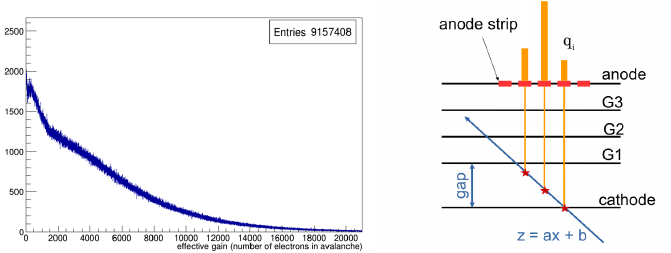
Figure 2: Left: e ff ective gain for a triple-GEM. The histogram is the result of the full chain of simulations of the gain, collection and extraction e ffi ciencies for the three GEMs. The contribution of zero e ff ective gain is removed from the histogram. Right: sketch of a triple- GEM detector with the cathode, three amplification stages and the anode. Each strip measures time and charge and continuous strips are used for CC and µ TPC reconstruction